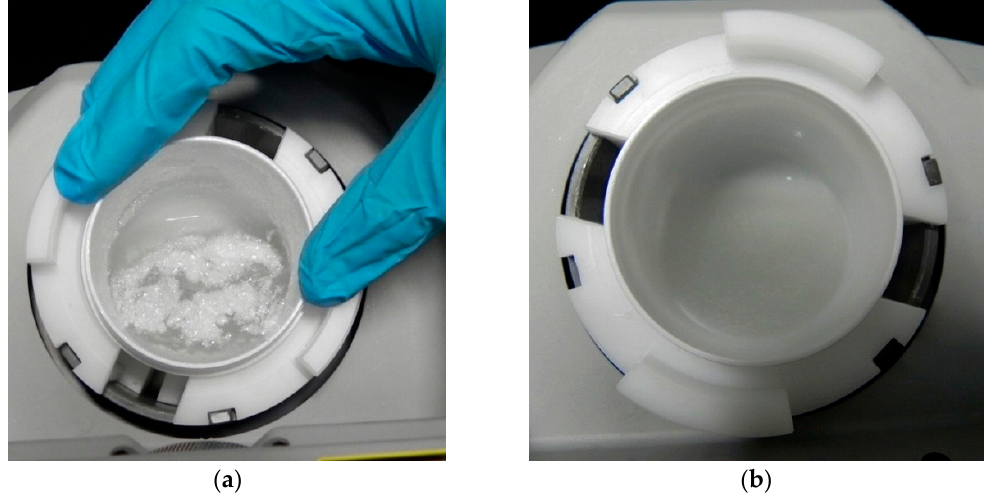
Figure 5. Polyvinyl Butyral (PVB)–MGF slurry before ( a ) and after ( b ) mixing in the planetary mixer.